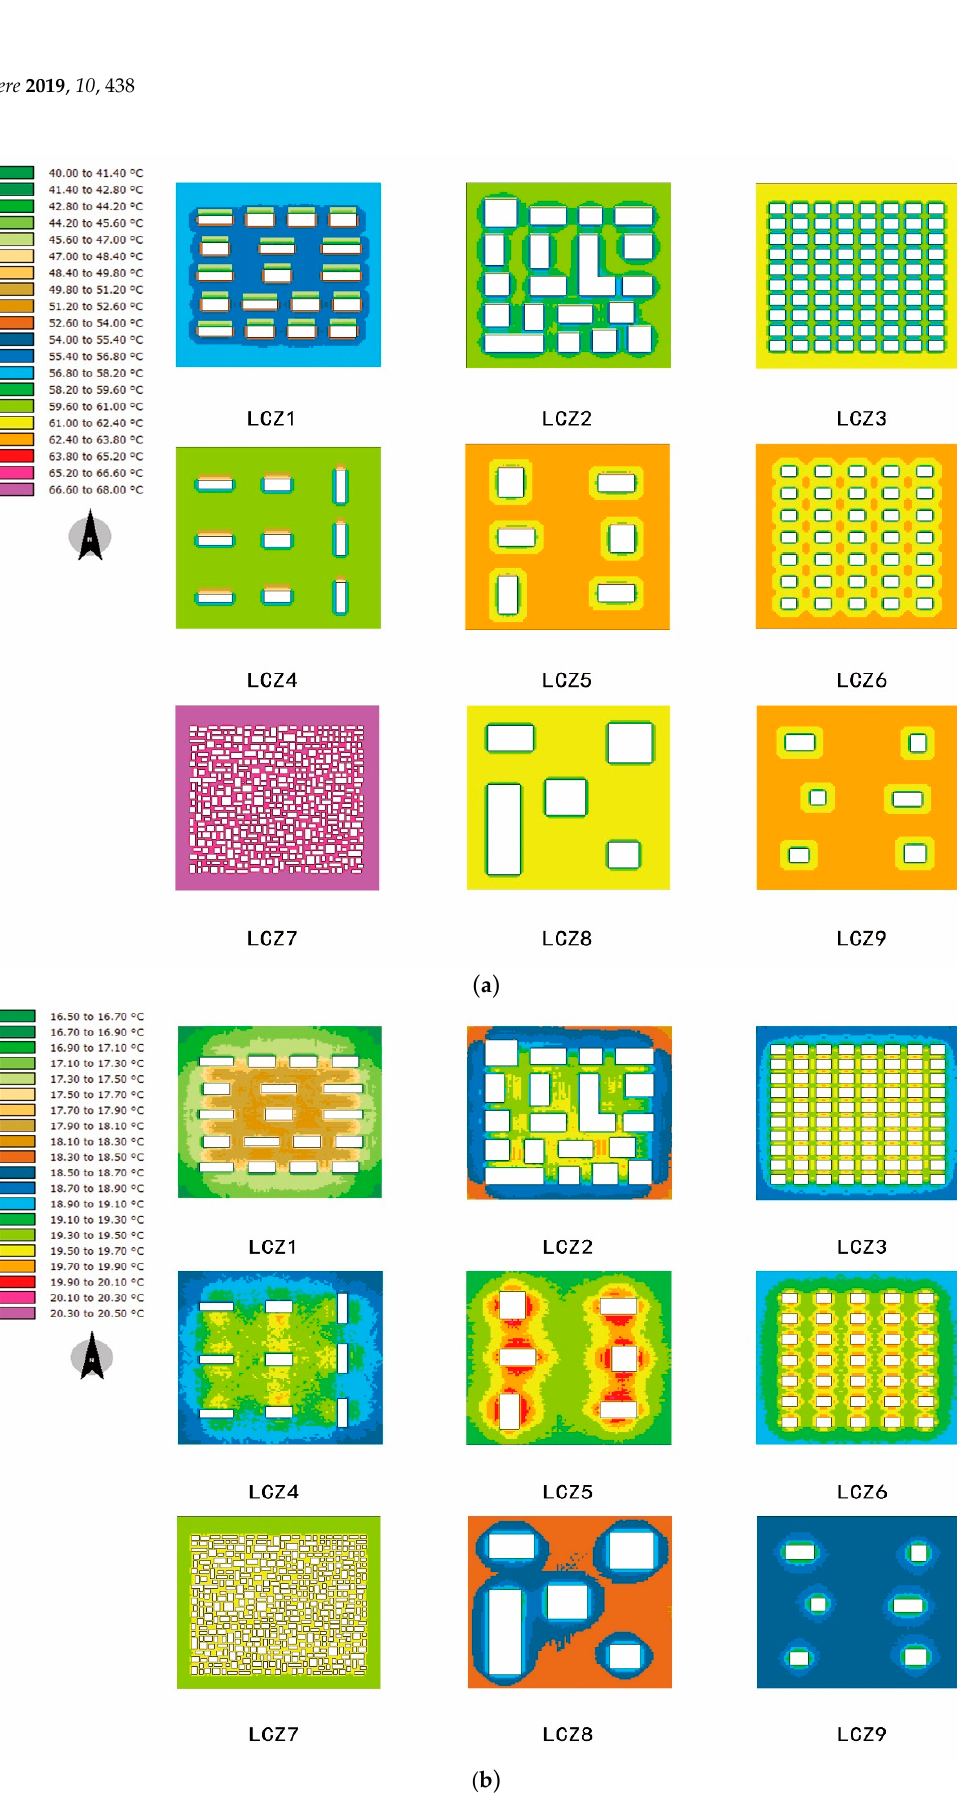
Figure 5. Distribution of mean radiant temperature (MRT) at 12:00 ( a ) and 21:00 ( b ) for all the nine models.